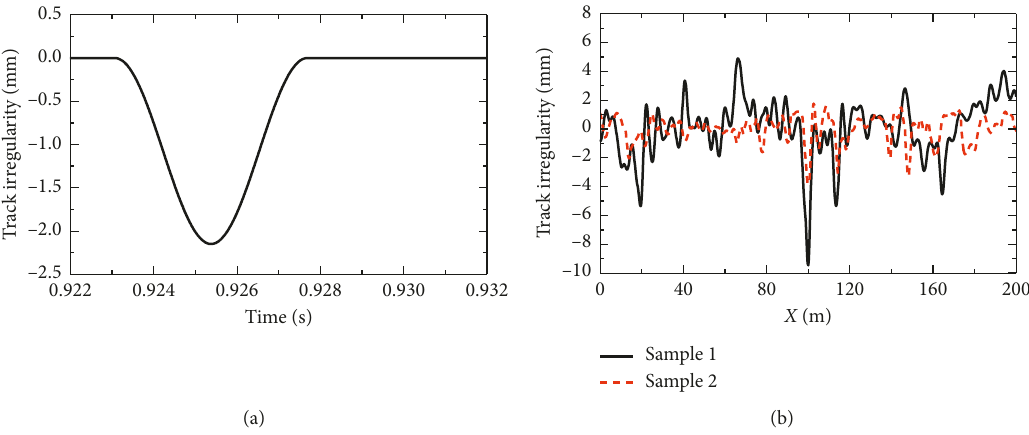
Figure 5: Track irregularities: (a) track irregularity of a wheel flat; (b) the measured random track